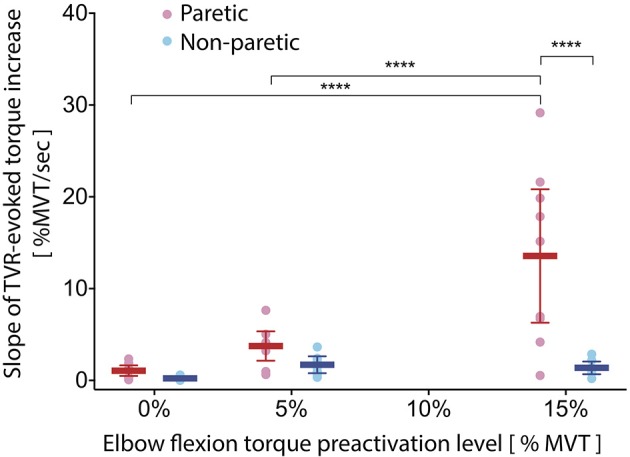
Slope of TVR-evoked torque increases with preactivation only in paretic limb. As preactivation level increases, the slope of TVR-evoked torque increases in the paretic (pink/red) but not the non-paretic (light blue/royal blue) elbow flexors. Differences between limbs emerge at the 15% preactivation level. Individual circles represent single participant values; horizontal lines indicate group means, with error bars corresponding to 95% confidence intervals. Y-axis: slope of TVR-evoked torque (%MVT per second); x-axis: elbow flexion torque preactivation level expressed as percent of MVT. ****p < 0.0001.